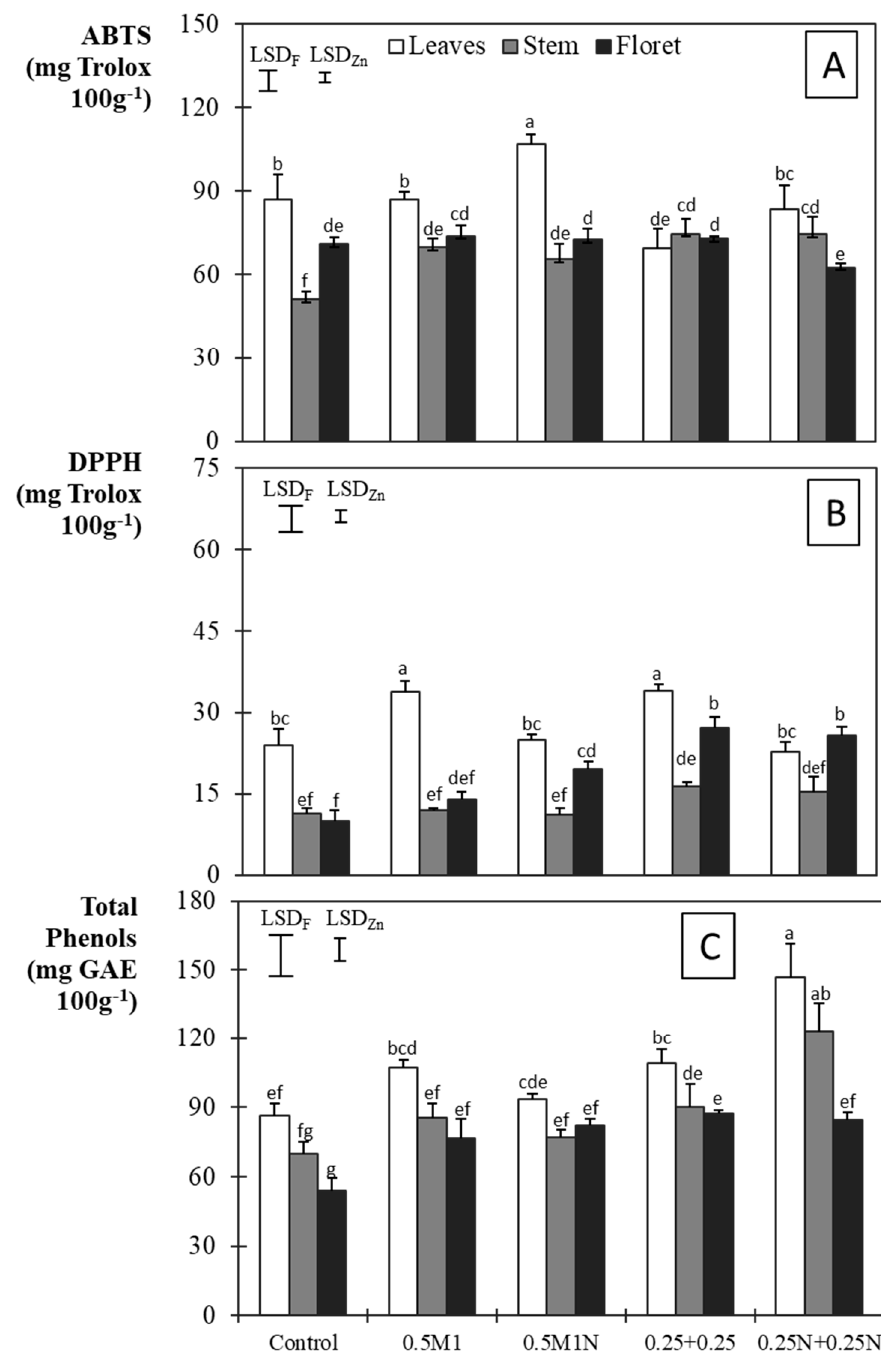
Figure 2. ABTS ( A ), DPPH ( B ), and total phenols ( C ) ± standard error of the mean. Vertical bars represent LSD ( p < 0.05) for comparison. LSD F : same broccoli fraction; LSD Zn : same Zn treatment. Different letters represent a significant difference at the p < 0.05 level for each broccoli fraction and Zn treatment.